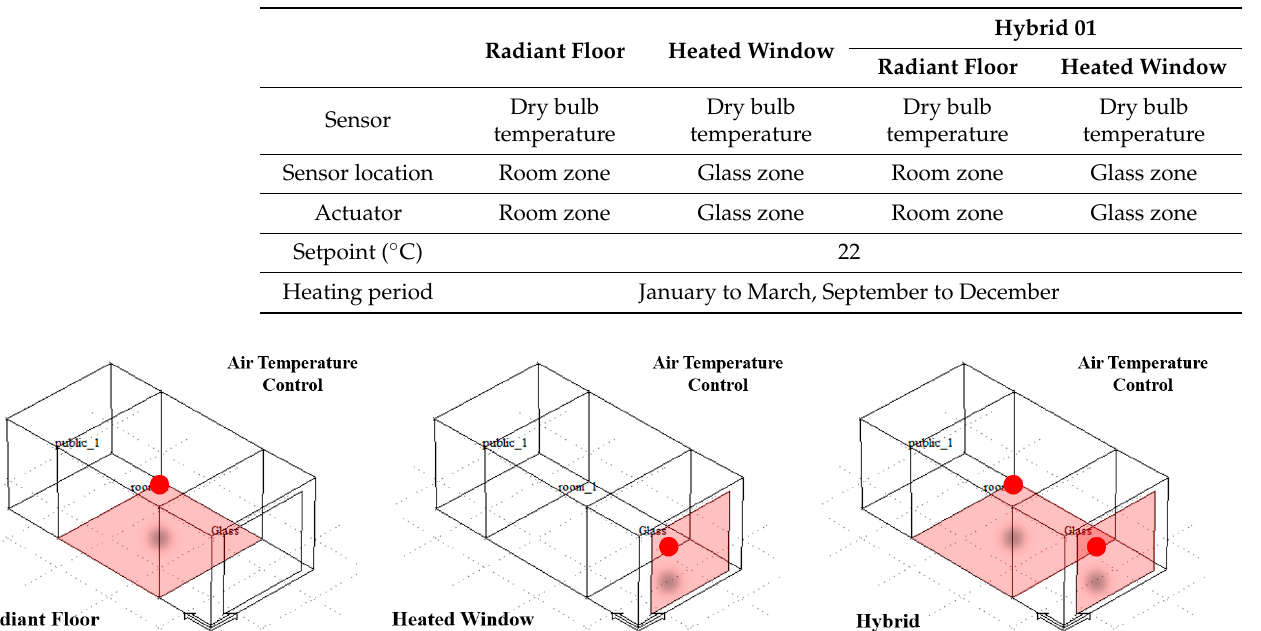
Table 3. Sensor, actuator, and setpoint of each heating system.